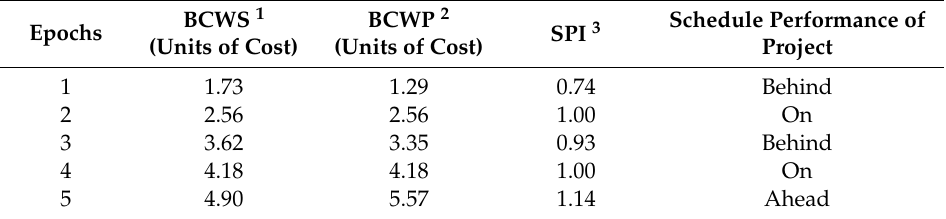
Table 4. Result of the earned value management to determine the project’s progress at each epoch.